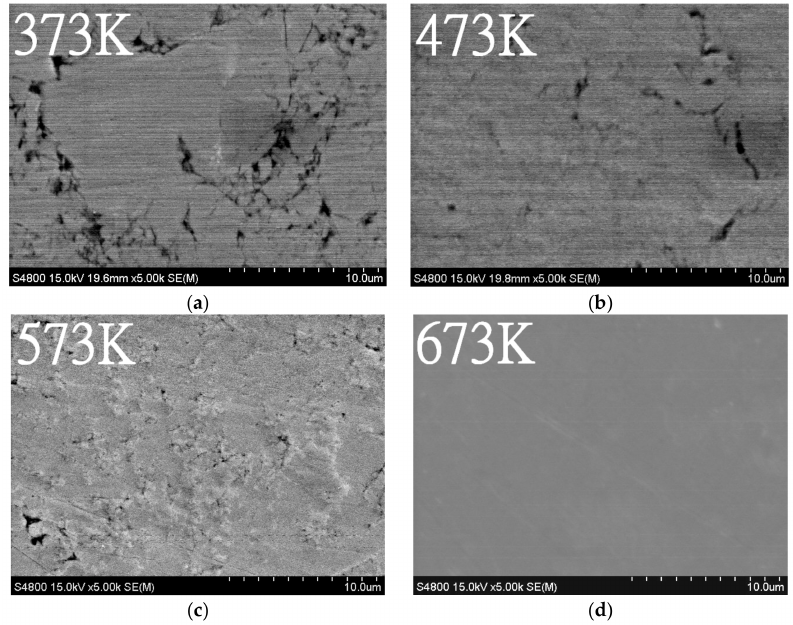
Figure 5. Scanning electron microscopy (SEM) micrographs of bulk specimen with 0.6 at. % Zn rich composition hot pressed at different temperatures. Pressure: 0.98 GPa, time: 30 min. ( a ) 373K; ( b ) 473 K; ( c ) 573 K; ( d ) 673